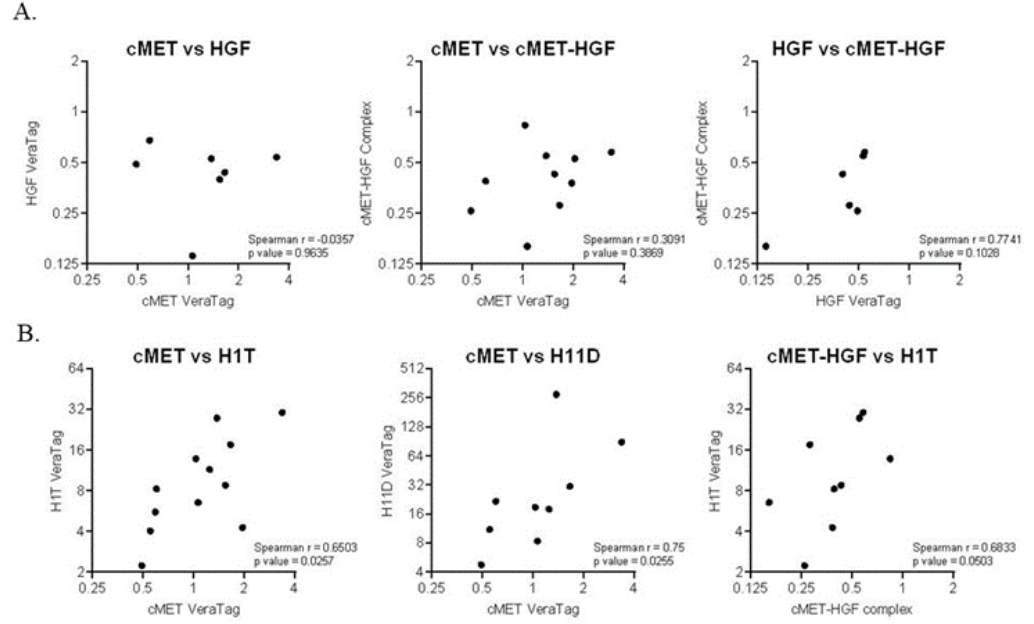
Figure 2. ( A ) Correlations between tumor cMet, HGF and cMet–HGF complex measured by VeraTag assays. ( B ) Correlations between cMet, EGFR (H1T) and EGFR homodimers (H11D) and the cMet–HGF complex and EGFR (H1T). Spearman correlation coefficients and p values are shown.